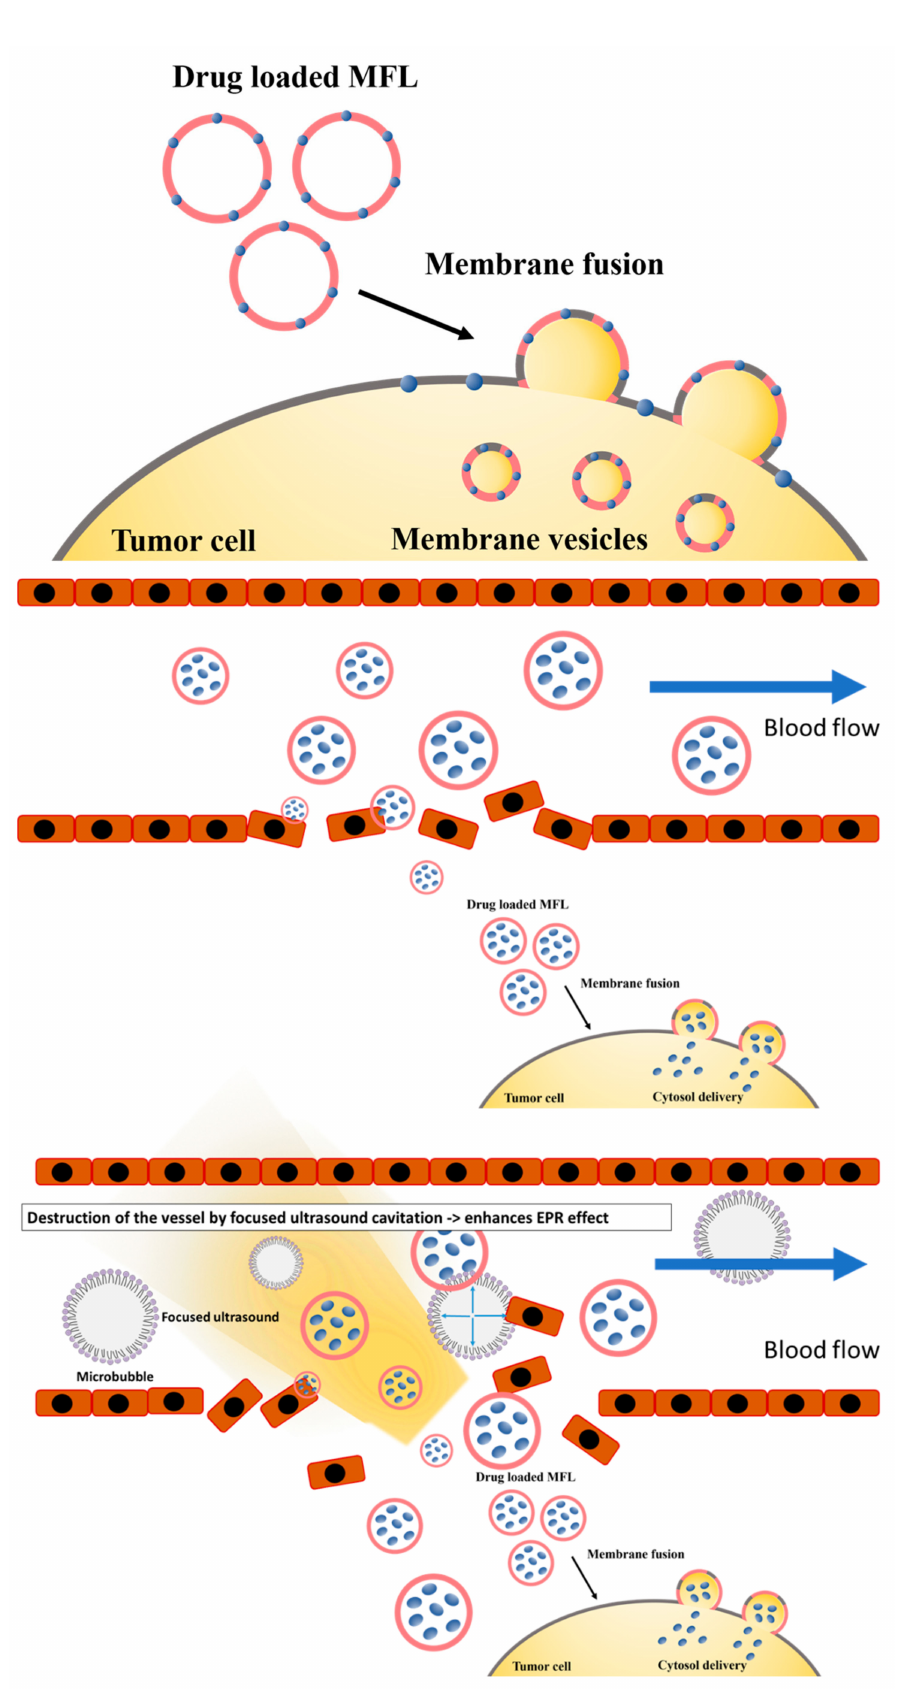
Figure 1. Graphical representation of membrane fusogenic liposomes (MFLs) and MFL-focused